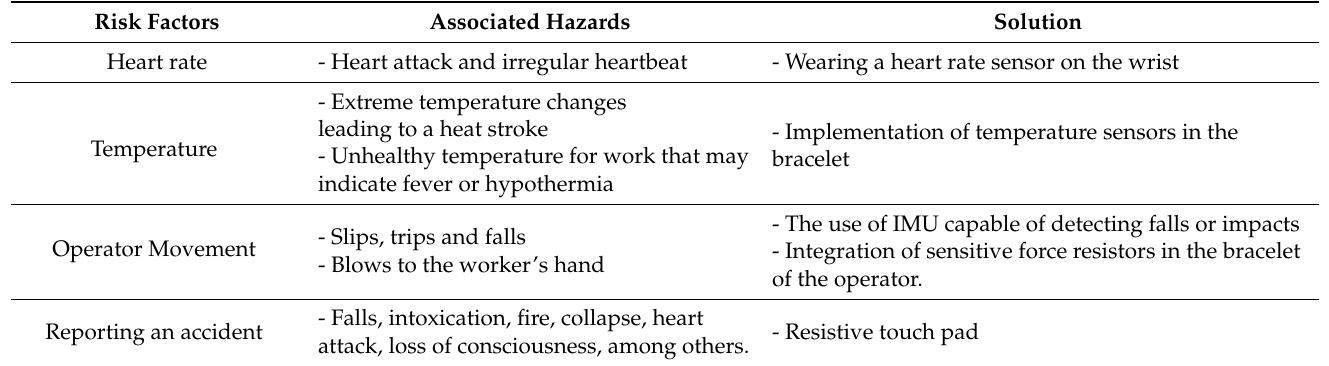
Table 2. Identification of common risk situations in the worker’s environment and electronic components.